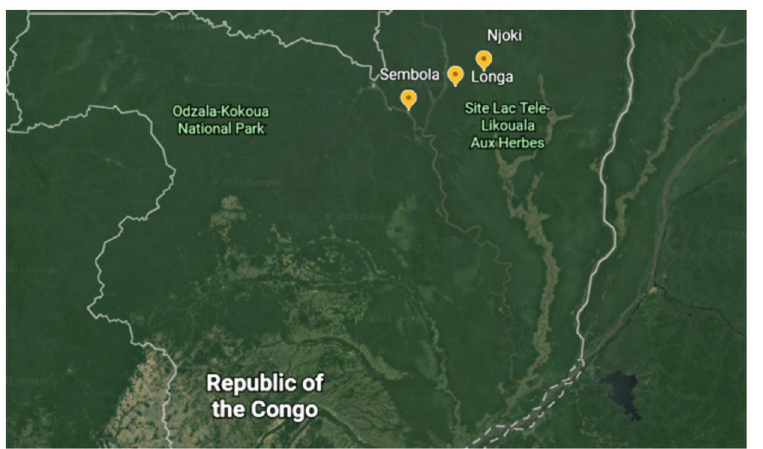
Fig 1. Map of study camps, constructed using Google